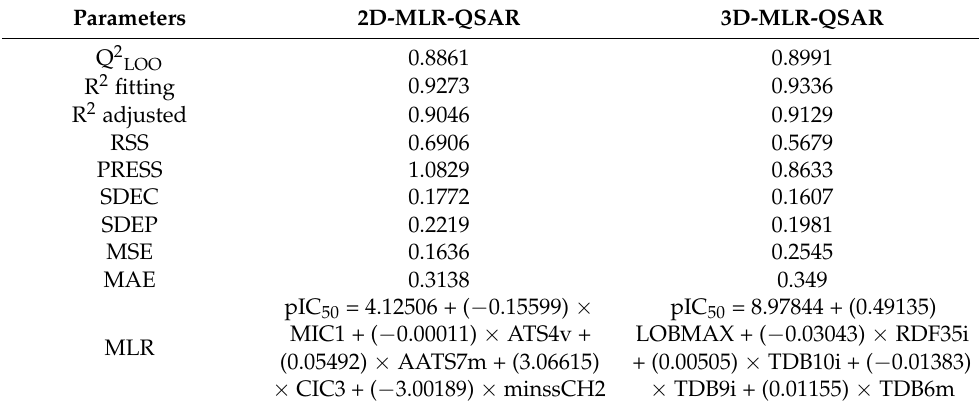
Table 2. MLR-QSAR models (2D- and 3D-descriptor optimized) of 27 dietary flavonoids and cross- validation